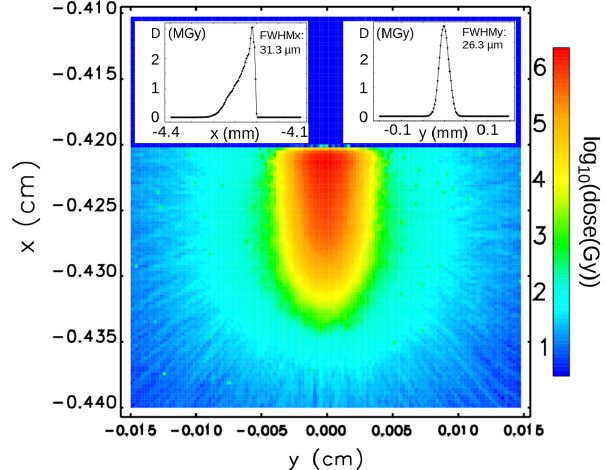
FIG. 9. Dose map at the collimator apex for a simulated APS-U 48-bunch, 200-mA whole-beam dump fill pattern using a 128 × 128 grid over an x-y domain of 0.3 mm by 0.3 mm (voxel size: 2 . 34 μ m). The dose is scaled to that for a single bunch. The insets plot the x- and y-dose profiles at the location of maximum integrated dose, yielding FWHM x ¼ 31 . 3 μ m and FWHM y ¼ 26 . 3 μ m.